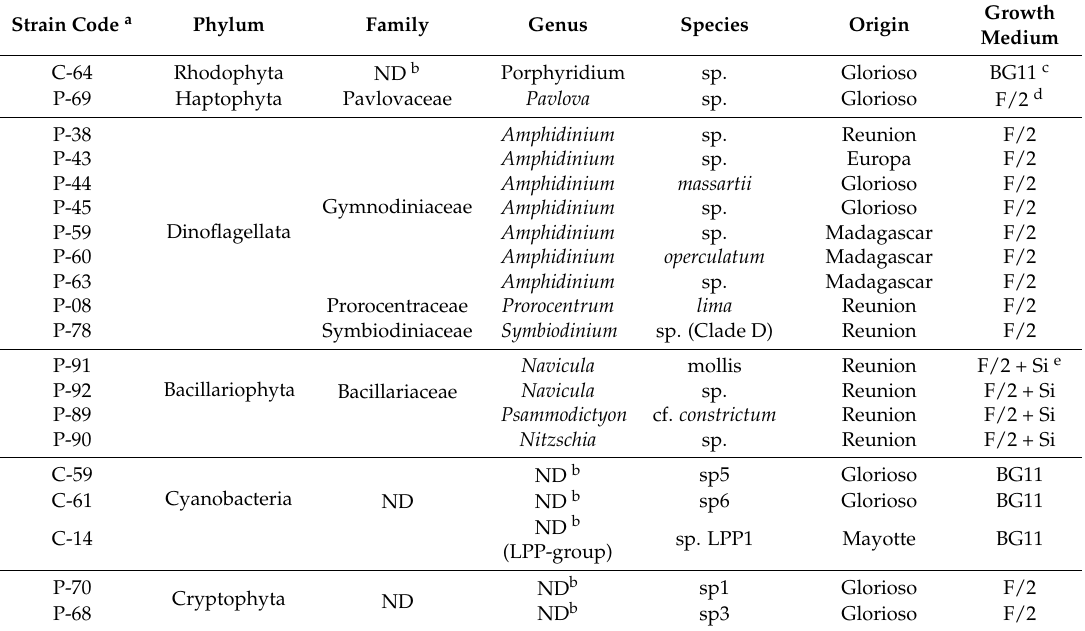
Table 6. Description of the microalgal strains used in this